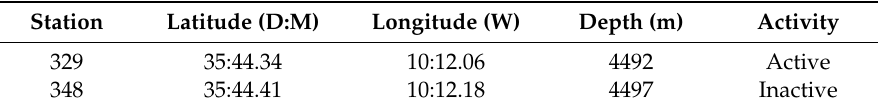
Table 1. Description of sampling stations at the Mikahail Ivanov mud volcano. Station Latitude (D:M) Longitude